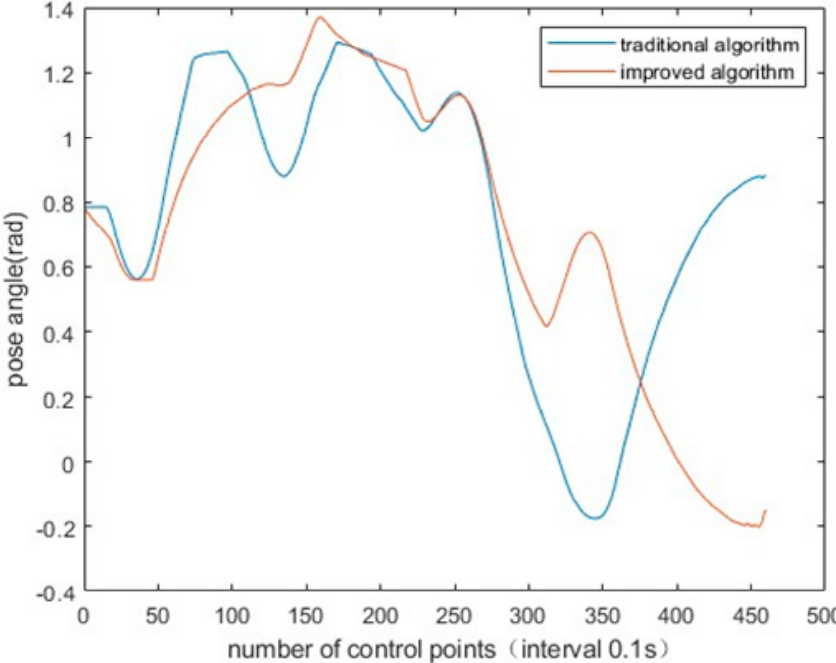
Figure 10. Improved algorithm and traditional algorithm for AGV pose.